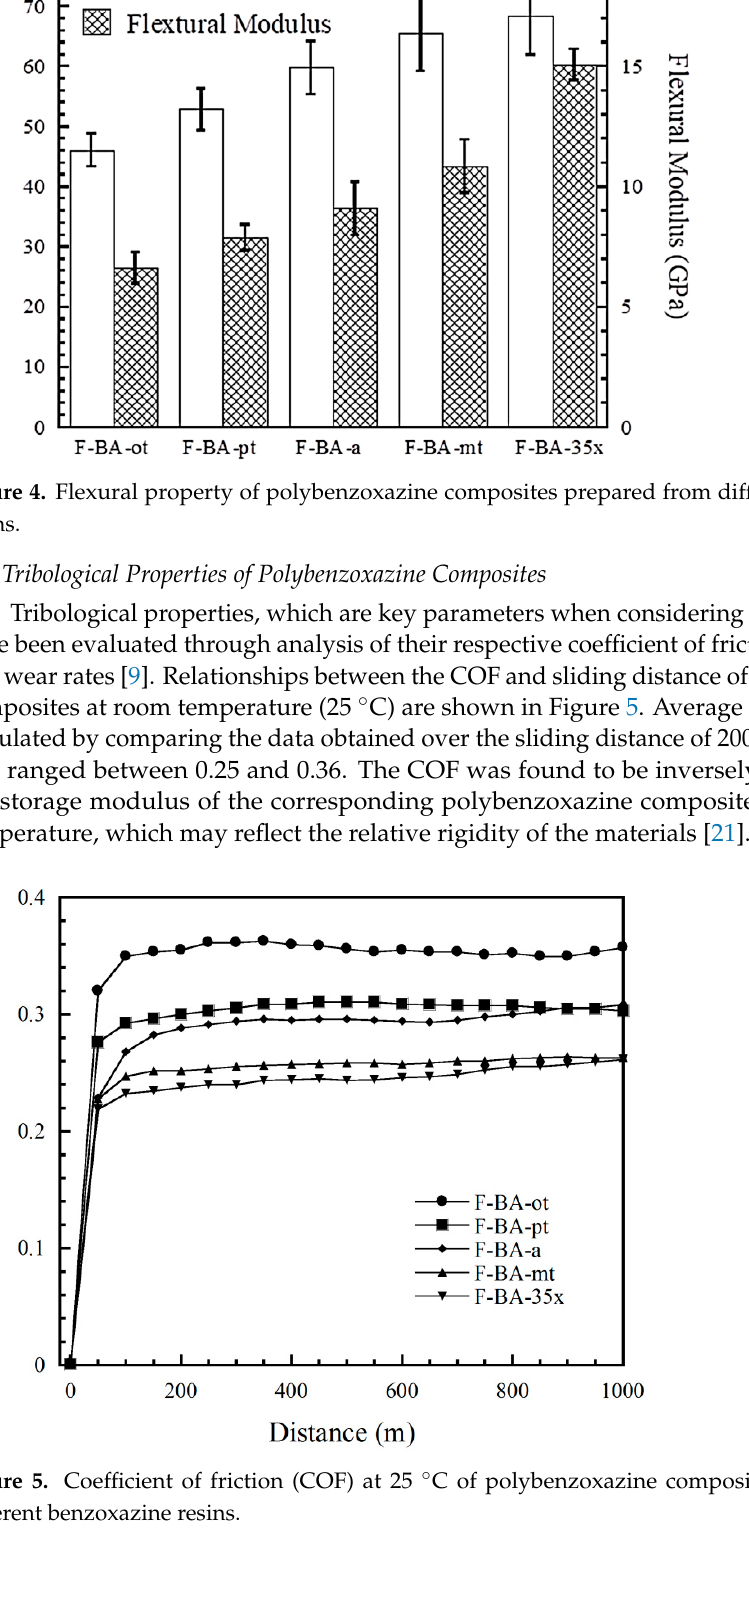
Figure 6. Specific wear rate at 25 °C of polybenzoxazine composites prepared from different ben- zoxazine resins.